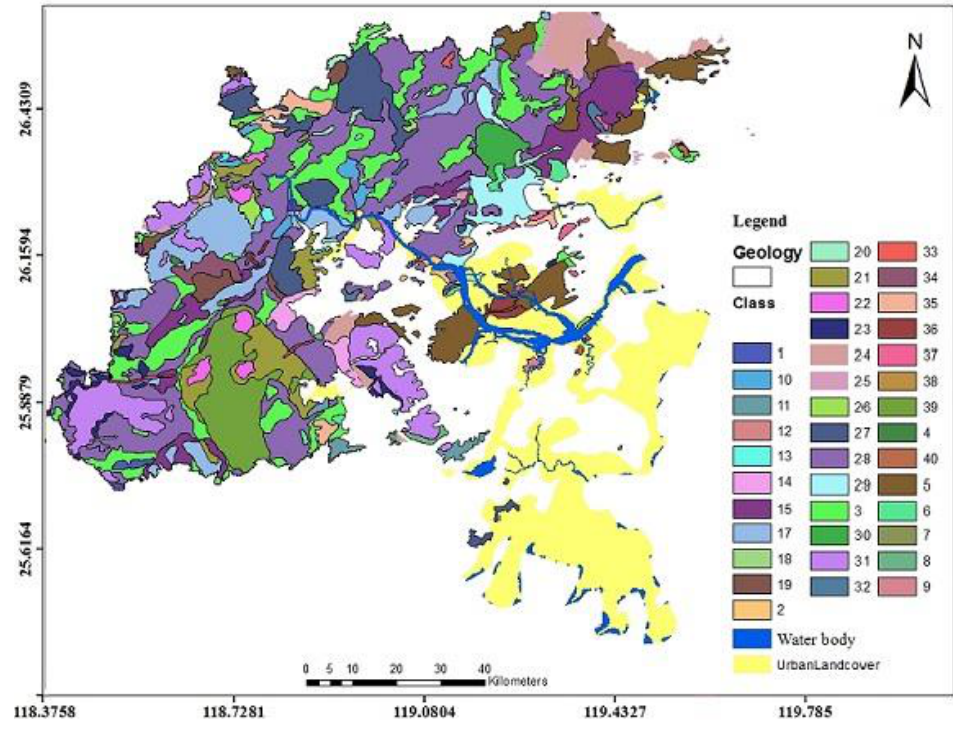
Figure 2. Geological map of the study area, Fujian, Fuzhou, the key is added to the Appendix